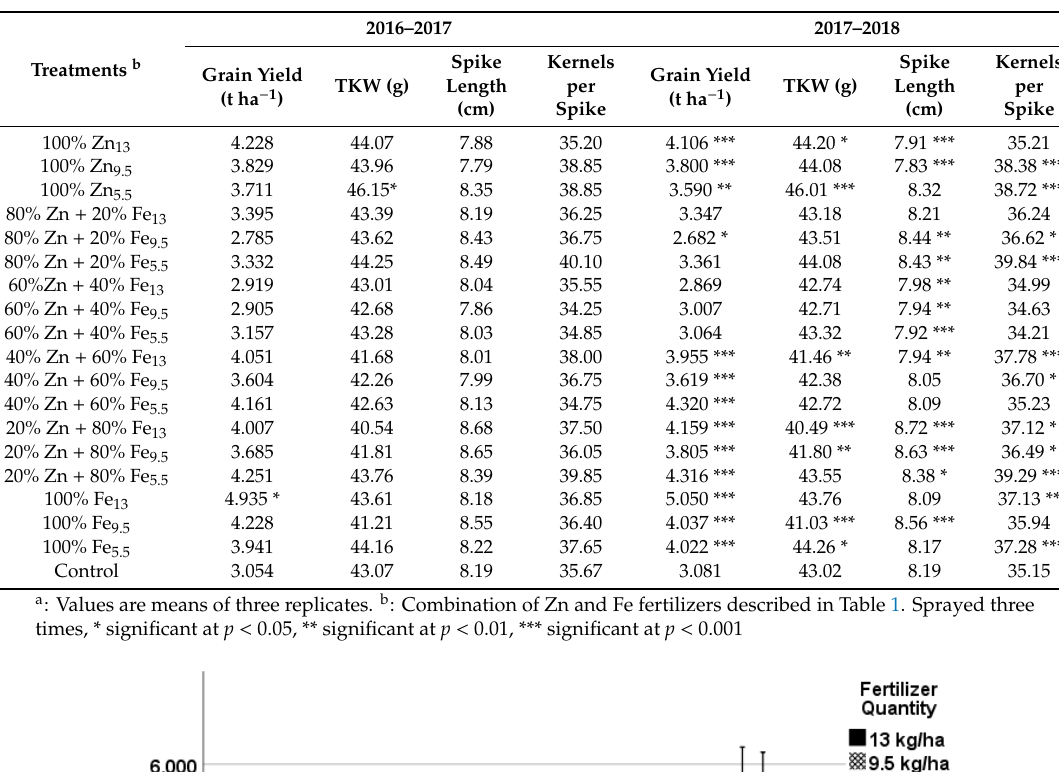
Table 3. Grain yield, thousand kernel weight (TKW), spike length and kernels per spike means comparison against control, as a ff ected by foliar application of Zn and Fe fertilizers a .